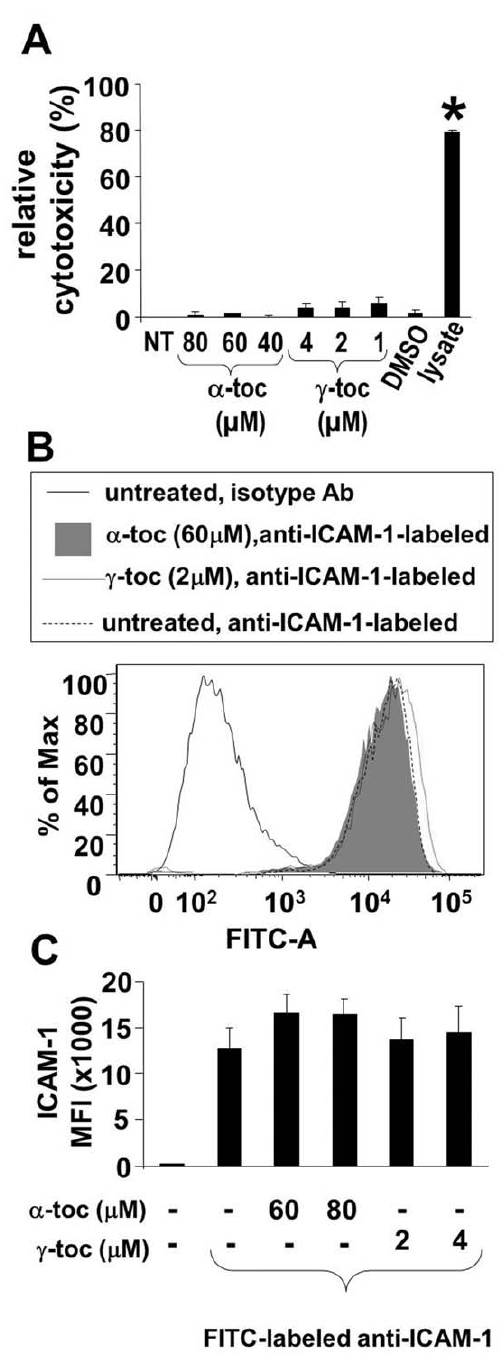
Figure 4. Tocopherol treatment of TNF a -stimulated HMVECLs was not cytotoxic and did not alter ICAM-1 expression. 70% confluent monolayers of HMVECLs were pretreated for 6 hrs with TNF a (10 ng/ml) to induce ICAM-1 expression. Then, the endothelial cells were treated for 16 hrs with a -tocopherol ( a -toc) (40, 60 or 80 m M), c - tocopherol ( c -toc) (1, 2 or 4 m M) or the vehicle control DMSO (0.01%). The cells were examined for cytotoxicity with the A ) Vybrant Cytotoxicity Assay or examined by B,C ) immunolabeling with FITC- labeled anti-ICAM-1 and flow cytometry. Shown are the means 6 SEM from 3 experiments. MFI, mean fluorescence intensity. *, p , 0.05 compared with non-treated (NT) cells.